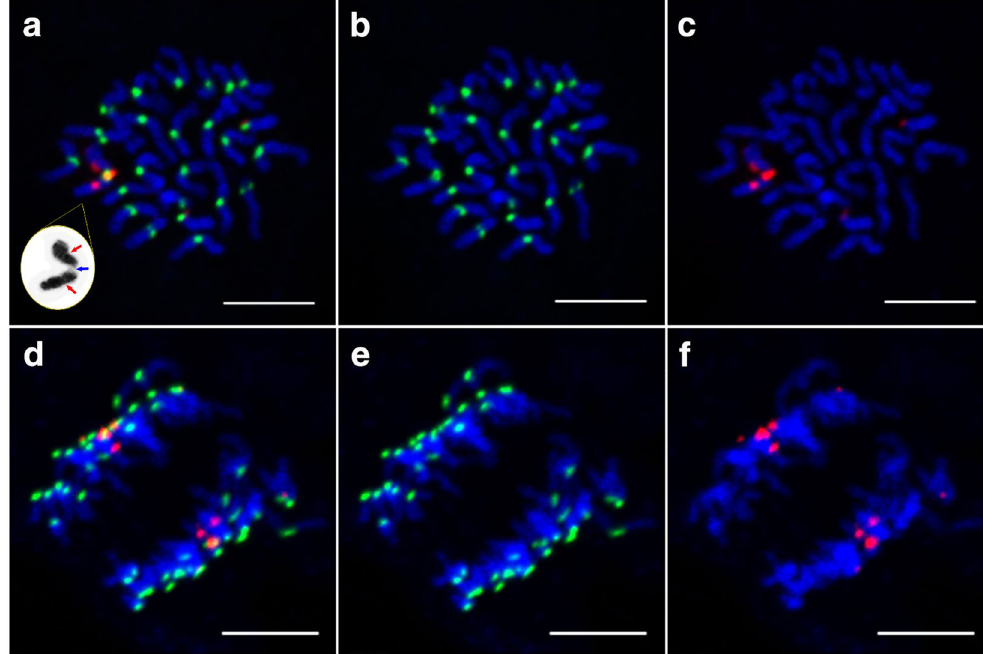
Figure 4. Localization of CENH3 and 5S rDNA during mitosis in variant YZG-5. Chromosomes were counterstained with DAPI. Red signals indicate 5S rDNA and green signals indicate CENH3. Scale bars represent 5 μ m in all images. ( a - c ) Distribution of CENH3 and 5S rDNA signals on somatic chromosomes at mitosis prometaphase in variant YZG-5. As shown with a yellow arrow, only one CENH3 signal overlaps with the middle 5S rDNA signal on the structurally tricentric chromosome. White arrows indicate 11L∙. In figure a , the panel for DAPI stained 11S∙11S∙11S∙11S is indicated by grayscale, with three centromeric regions shown by blue and red arrows. ( d – f ) Distribution of CENH3 and 5S rDNA signals on somatic chromosomes at mitosis anaphase. The structurally tricentric chromosome with one CENH3 signal divided